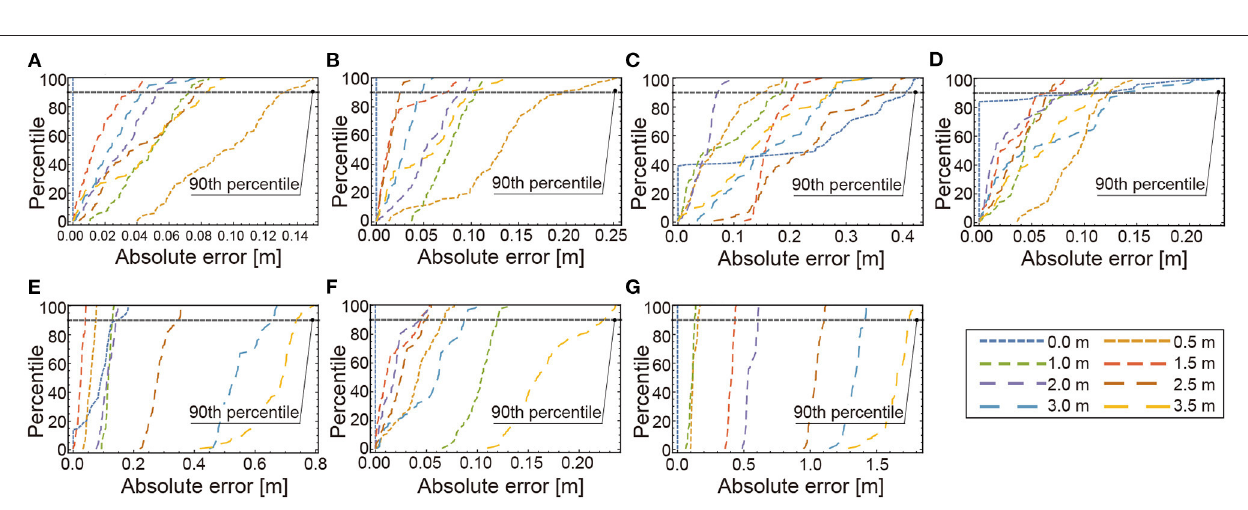
FIGURE 7 | CDF of absolute errors of estimated distance using each material. (A) White mat, (B) gray mat, (C) black mat, (D) non-gow wood, (E) glow wood, (F) marble and (G) artificial grass.